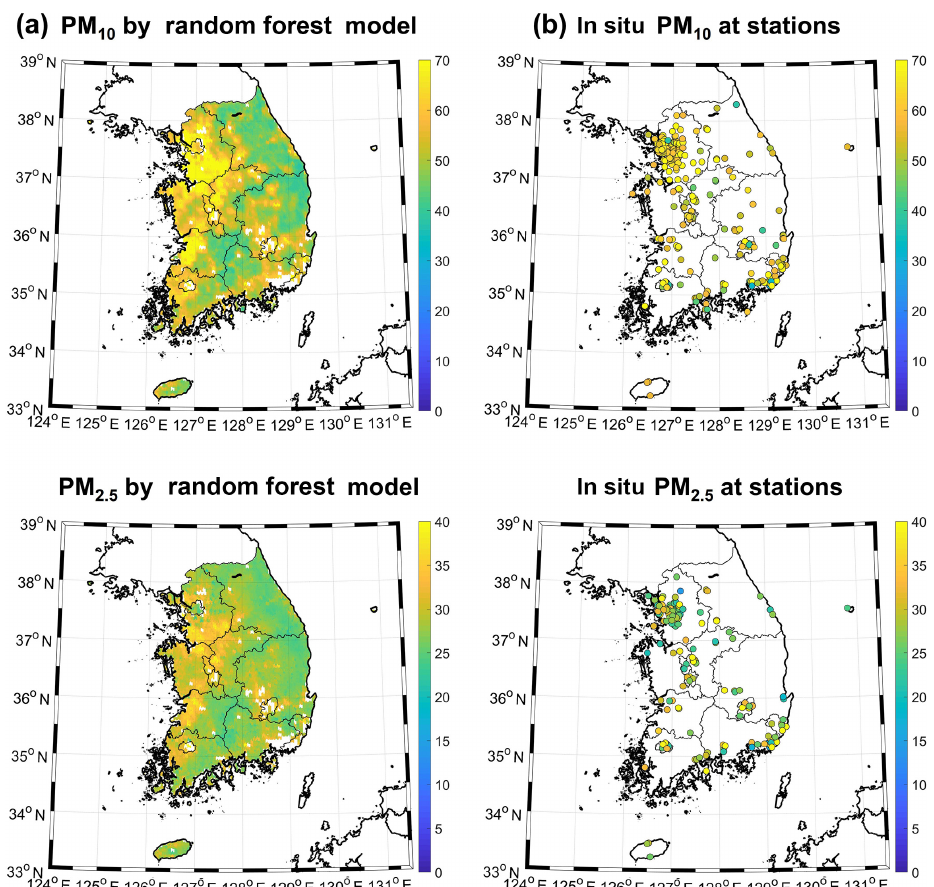
Figure 5. Maps of 2-year averaged particulate matter concentrations: PM 10 and PM 2 . 5 by the RF model (a) , and in situ PM 10 and PM 2 . 5 (b) .